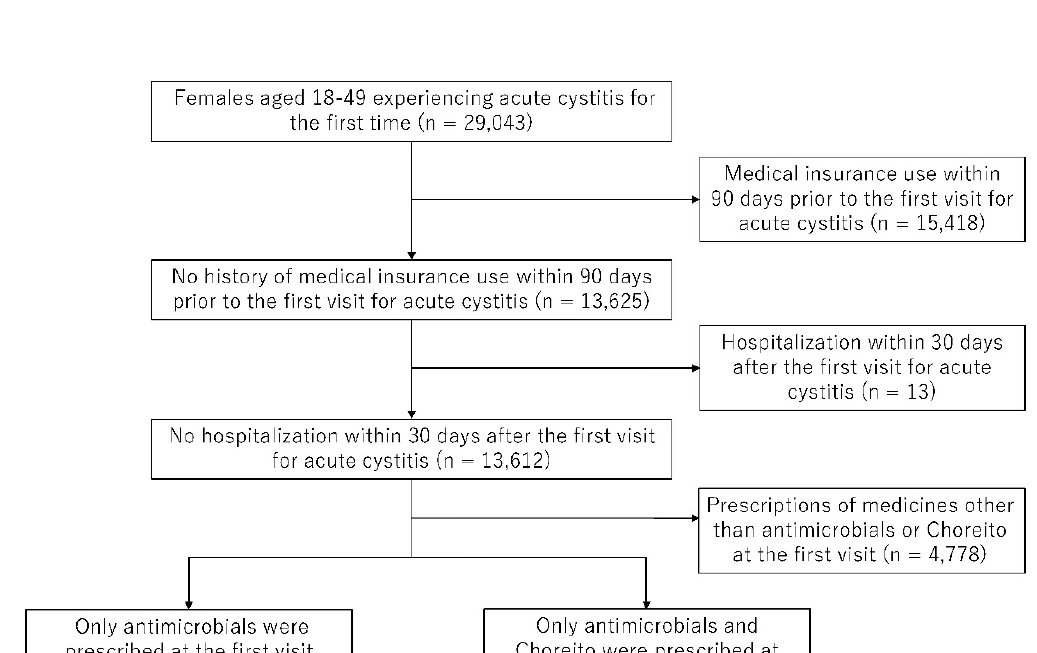
Table 1. Characteristics and outcomes of 8834 females with acute cystitis receiving antimicrobials with or without Choreito (Kampo medicine) at their first clinic visit between Apr 2018 and Mar 2021.